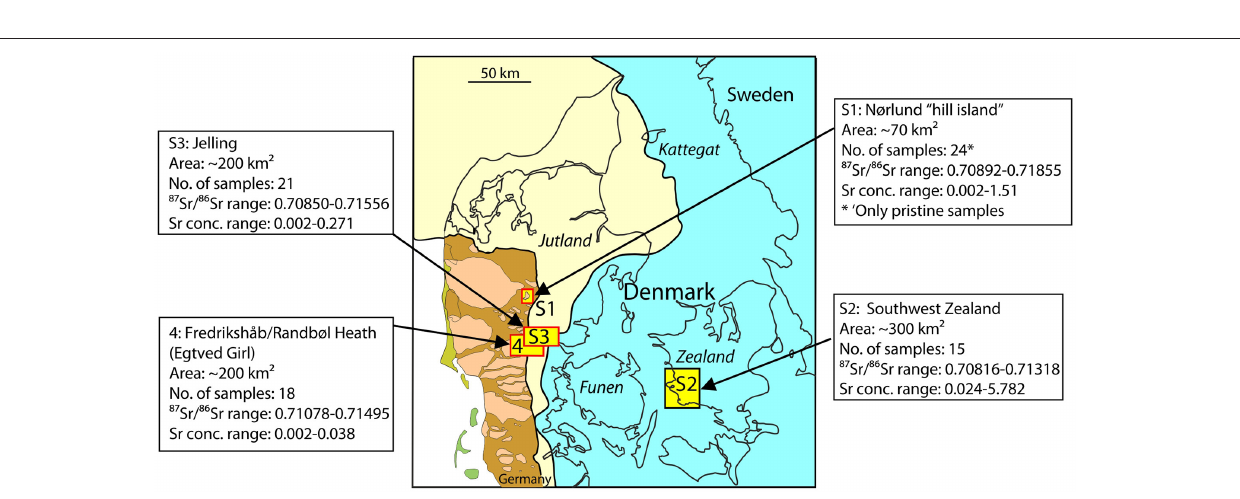
FIGURE 7 | Hillshade map of the study area S3 (Jelling). Location of sample stations is indicated by colored dots. For numbering of sample stations see Figure 6 . 87 Sr/ 86 Sr ratio and strontium concentration are shown for each sample. Sample stations with 87 Sr/ 86 Sr ratios exceeding the maximum value of 0.711 in the baseline for Denmark (Frei and Frei, 2011) are highlighted with a red box. Map is based on free data from “Styrelsen for Dataforsyning og Effektivisering, skyggekort, WMS-tjeneste”.